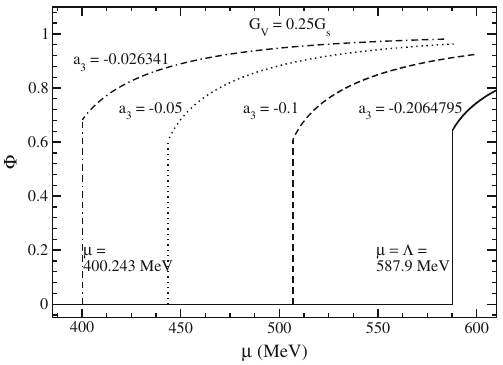
Fig. 6 The same as in Fig. 3, but for a larger μ region